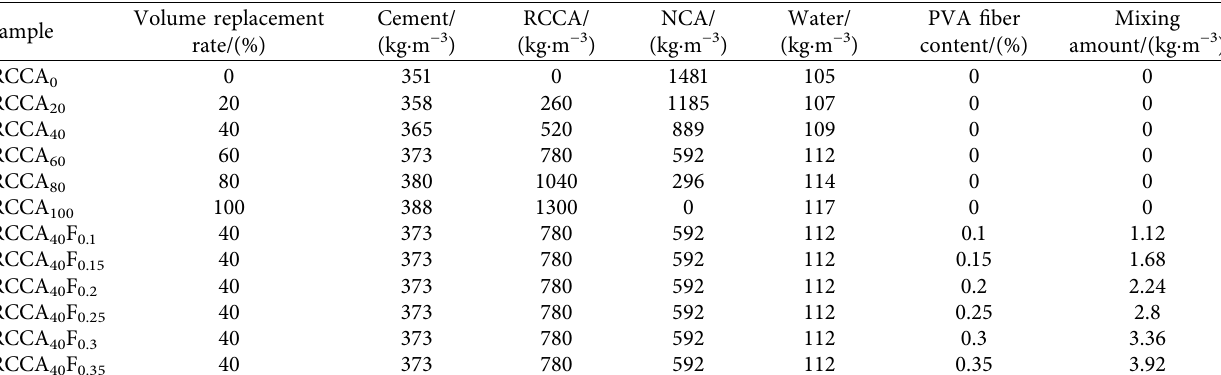
Table 2: Mix proportions of RCCAPC and PVA fiber-reinforced